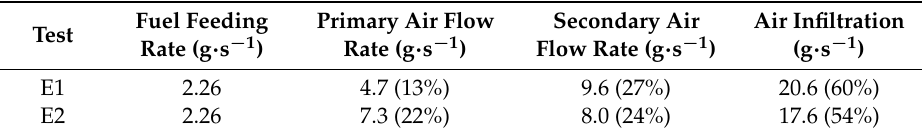
Table 3. Operating conditions for the experimental tests.